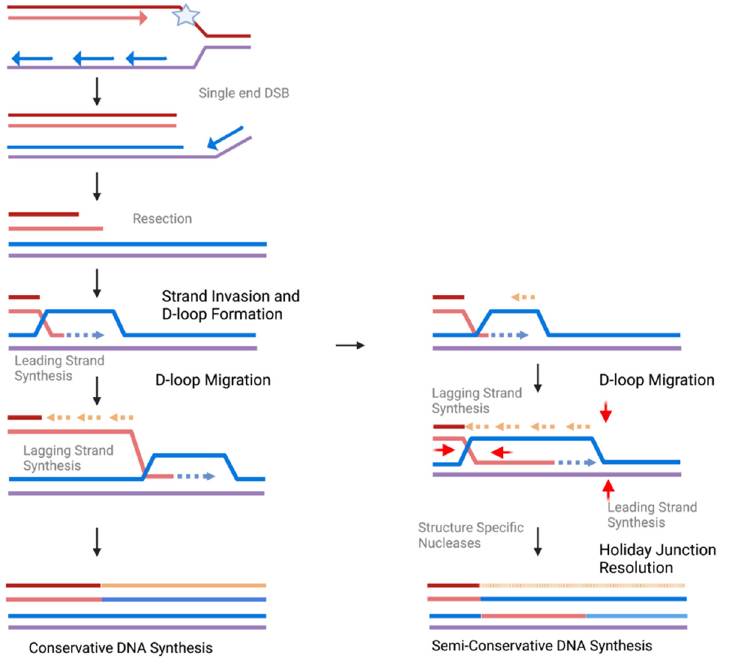
Figure 2. Schematic of DNA Synthesis During MiDAS . When a replication fork collapses following replication stress (star), a single-ended double-strand break forms. After resection, the 3 ′ overhang of the recipient strands (red/orange) can invade the donor stands (blue/purple). After D-loop formation, if lagging-strand synthesis takes place on the invading stand, no new synthesis will occur for the donor strand, resulting in conservative DNA repair synthesis. If instead lagging-strand synthesis occurs on the extruded donor D-loop strand, following D-loop migration structure specific nucleases (red arrows) will resolve the holiday junction. This results in new synthesis for both the donor and receipt and is semi-conservative DNA repair synthesis. Created in BioRender.